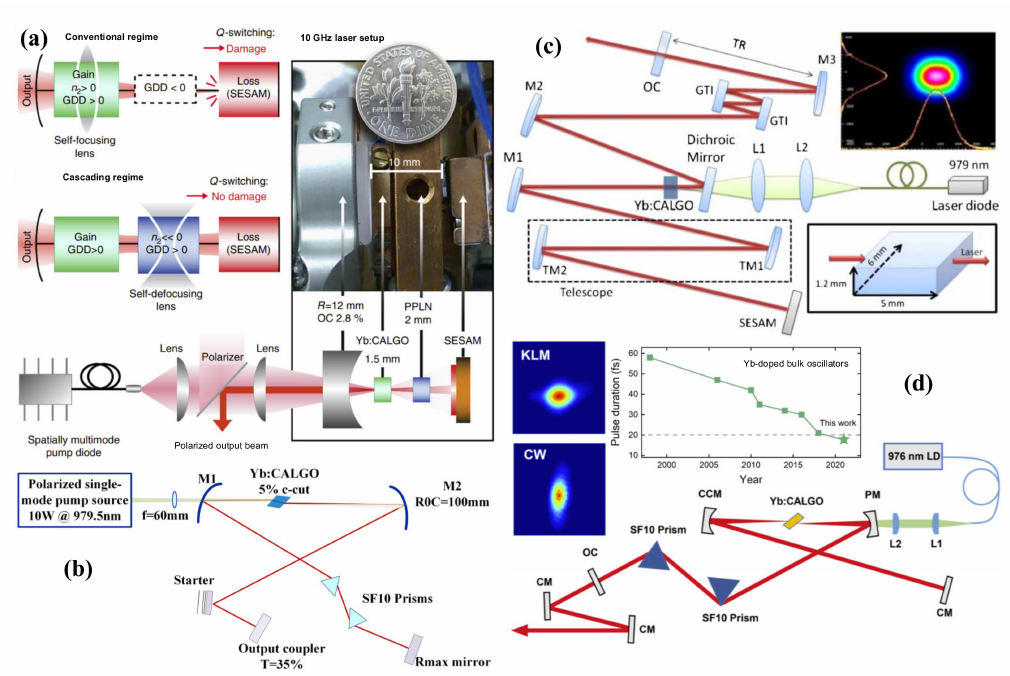
Figure 4. Ultrashort pulse Yb:CALGO lasers by leveraging ( a ) SESAM mode locking [99], ( b ) Kerr-lens mode locking [44], ( c ) both SESAM and Kerr-lens mode locking [45] and ( d ) Kerr-lens mode locking with broadband chirped mirrors and a prism pair [110] techniques. ( b ) is redrawn based on ref. [44]. ( c ) Reprinted with permission from ref. [45], ©The Optical Society. ( d ) Reprinted with permission from ref. [110], ©The Optical